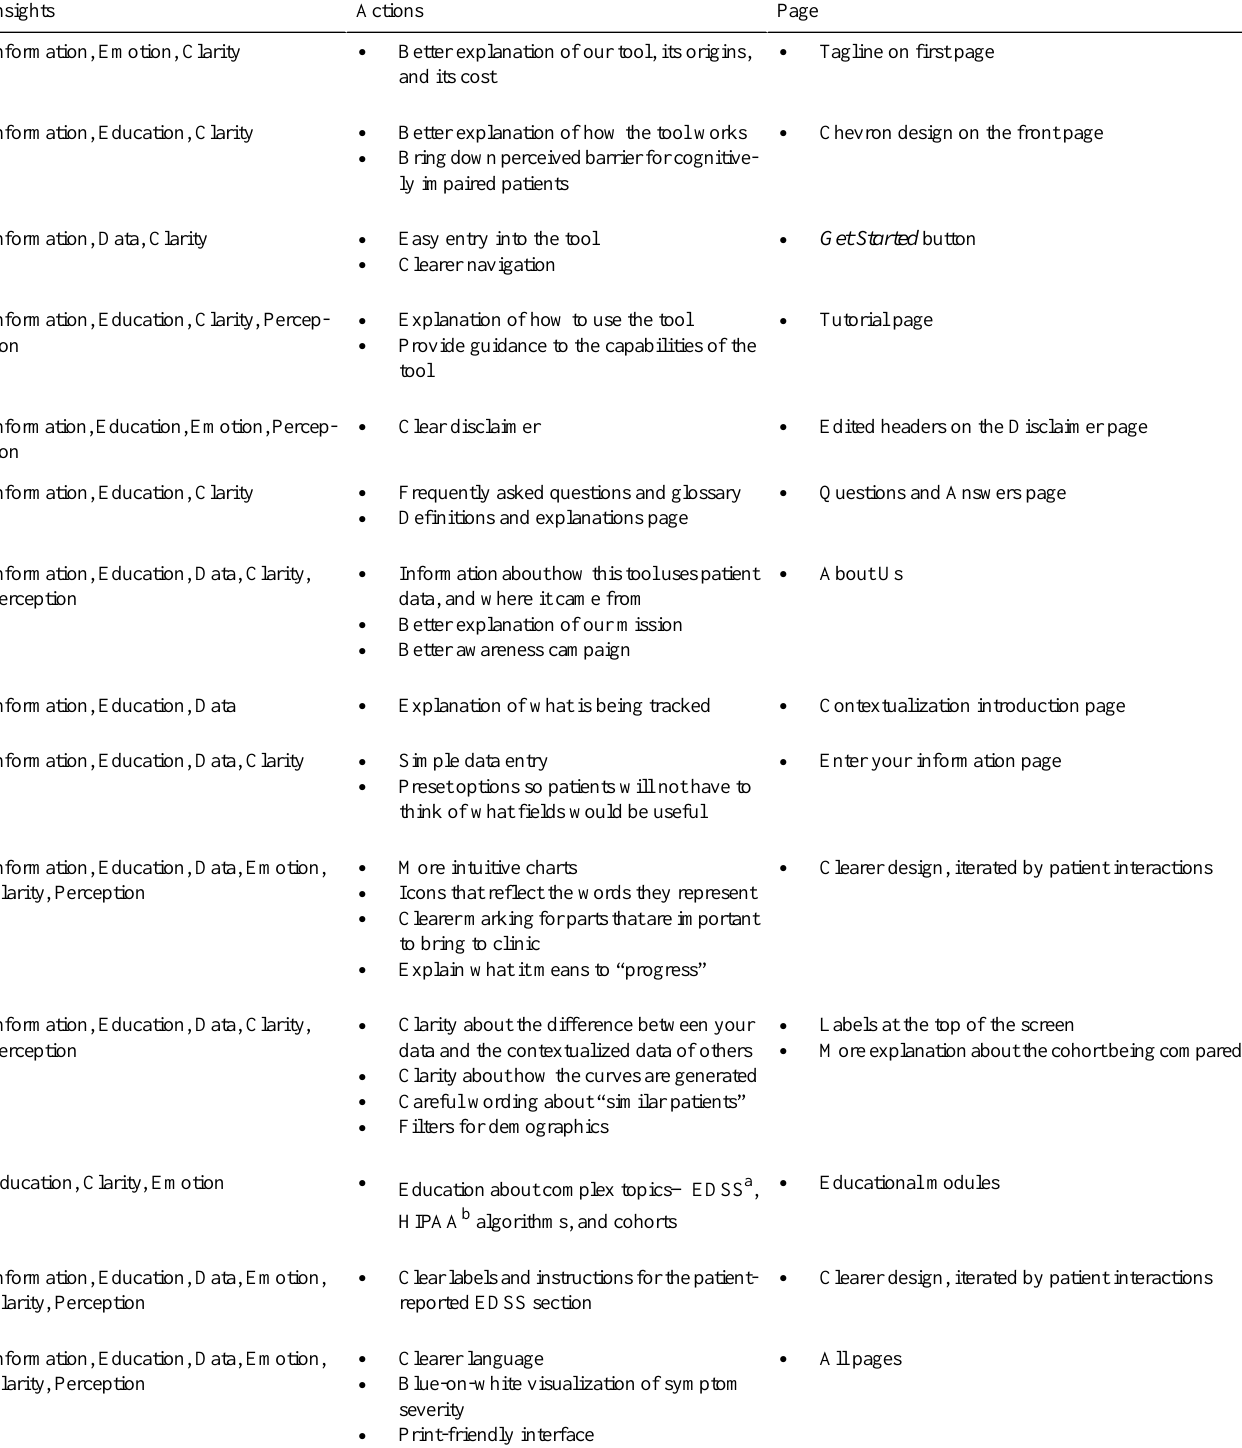
Table 4. Examples of actions taken during phase III (implementation) based on patient insights generated in phase